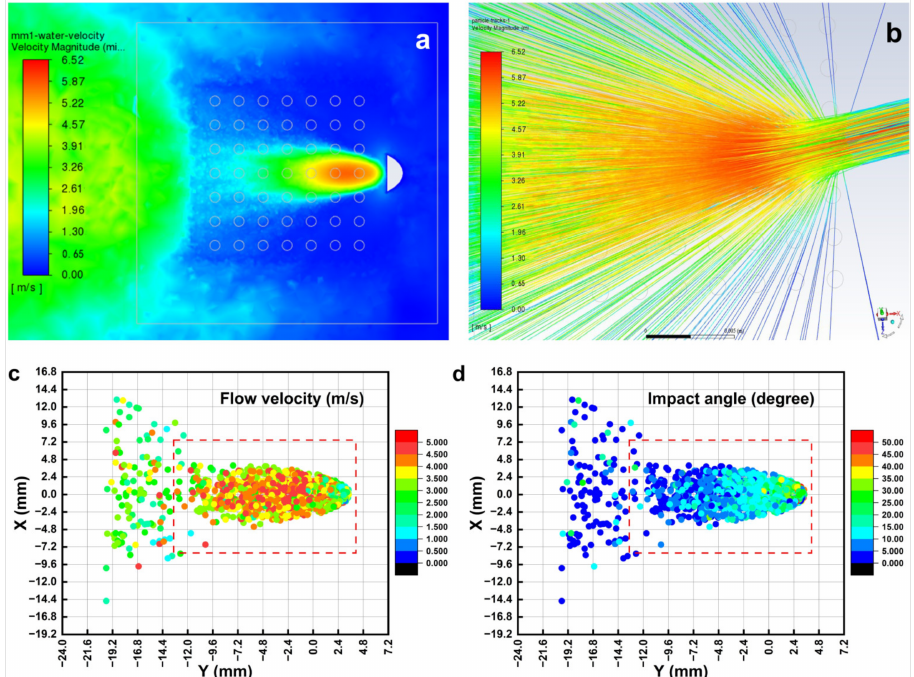
Figure 5. ( a ) Contours of total flow velocity and ( b ) sand particle trajectory along the flow direction, and the distribution of ( c ) total flow velocity and ( d ) impact angle of the WBE obtained and calculated from CFD simulation. The dashed rectangle in ( c , d ) represents the location of